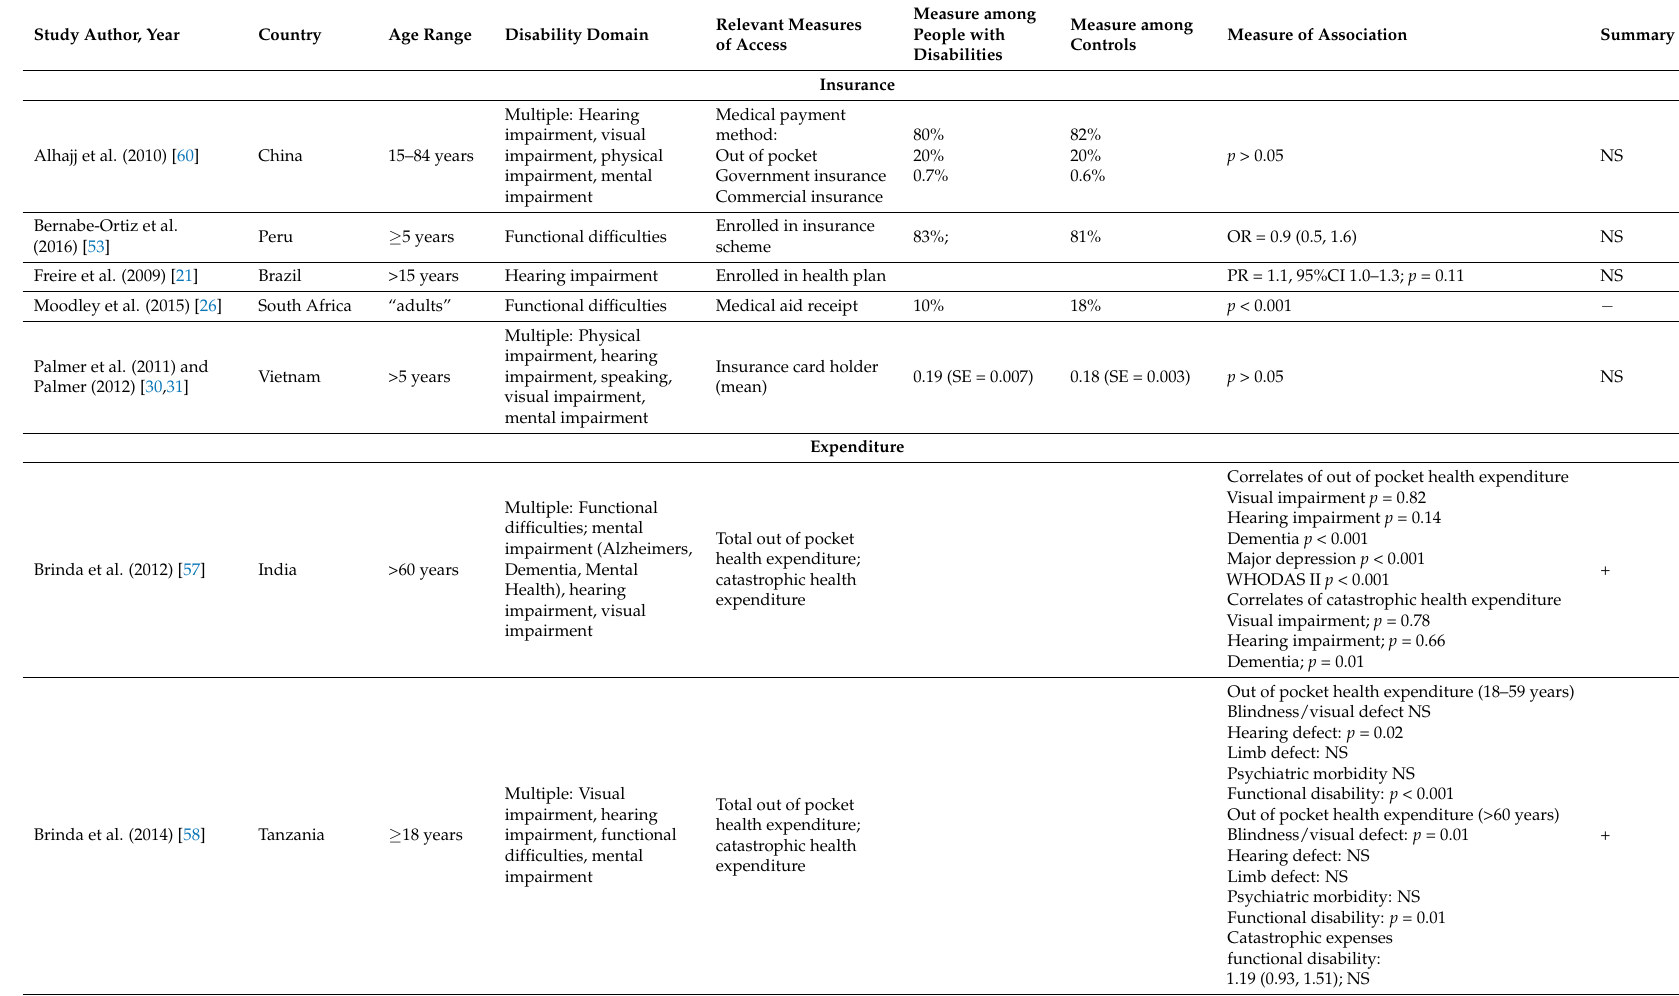
Table 7. Results of studies measuring insurance and